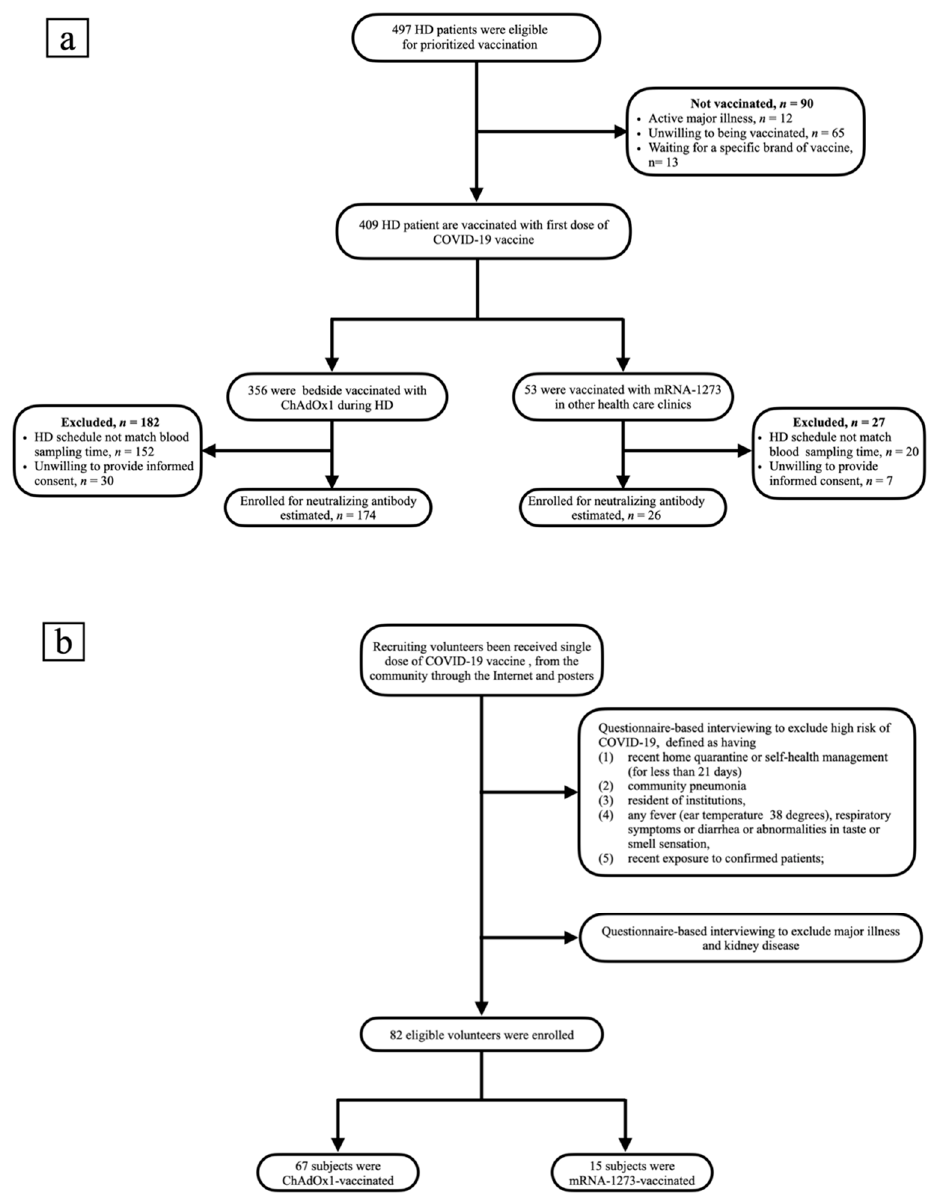
Figure 1. ( a ) Flow chart of patients on hemodialysis selected for neutralizing antibody measurement. ( b ) Flow chart of recruitment of healthy controls.